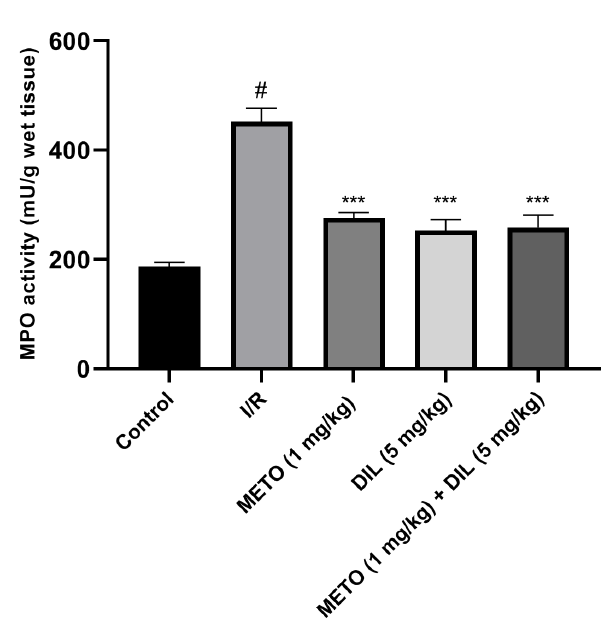
FIGURE 3 - The effects of pre-treatment with metoprolol (1 mg/kg/day) and diltiazem (5 mg/kg/day) alone and in combination on MPO activity in the brain tissue; data are expressed as mean±S.E.M. N=6. # P<0.001 vs. control group. *** P<0.001 vs. I/R group using one-way ANOVA with Tukey post-test. I/R: Ischemia/reperfusion; METO: